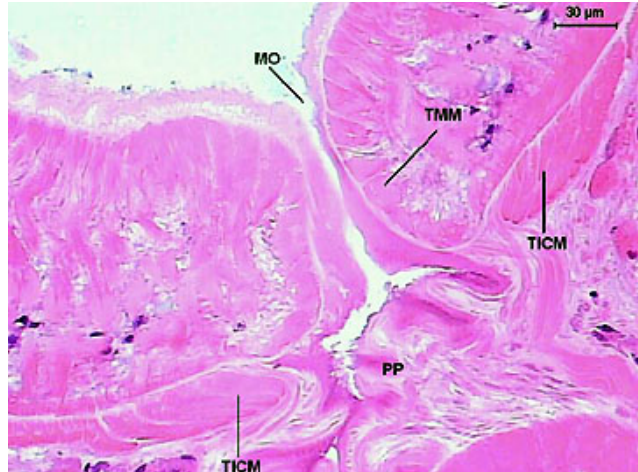
Figure 6. Longitudinal section of the mouth and prepharynx of Sticholecitha serpentis . M – mouth, PP – prepharynx, TMM – increased thickness of the mouth musculature, TICM – increased thickness of the internal circular musculature. HE.